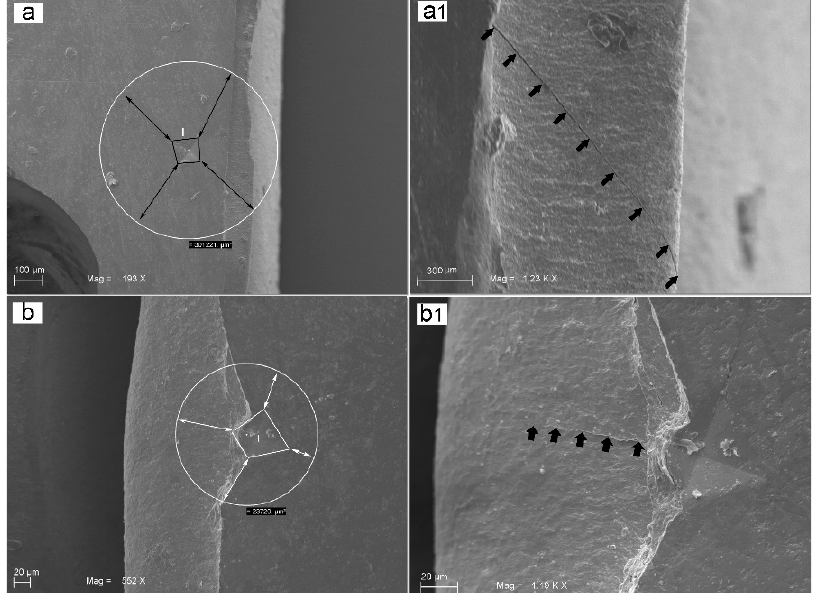
Figure 6. SEM images showing: ( a ) fracture and microcrack development at 193× magnification in group A. The surface area of the material involved by the four crack lines was 301 mm 2 ; ( a1 ) at higher magnification (1230×), the fracture propagation appears to involve the entire thickness of the specimen; ( b ) fracture and microcrack development at 552× magnification in group B. The surface area involved by the four crack lines was 23 mm 2 ; ( b1 ) at higher magnification (1190×), the fracture propagation appears to partially involve the specimen thickness.